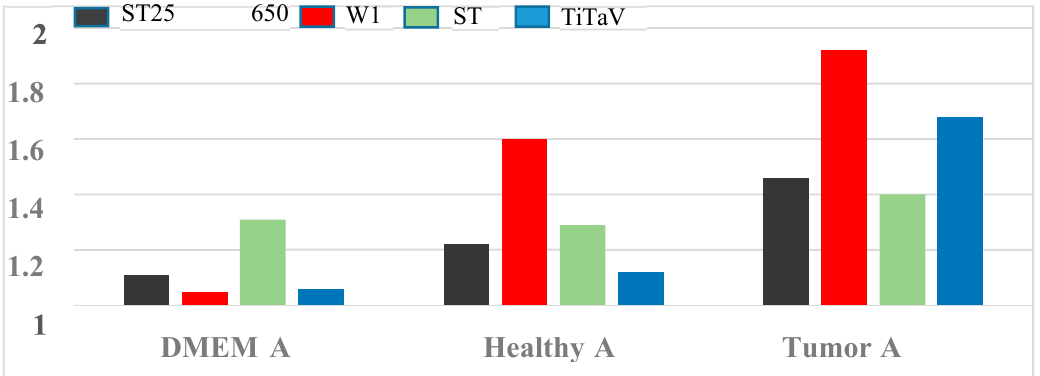
Figure 1. Histogram of the responses of four different sensors to the cell samples exhalations.